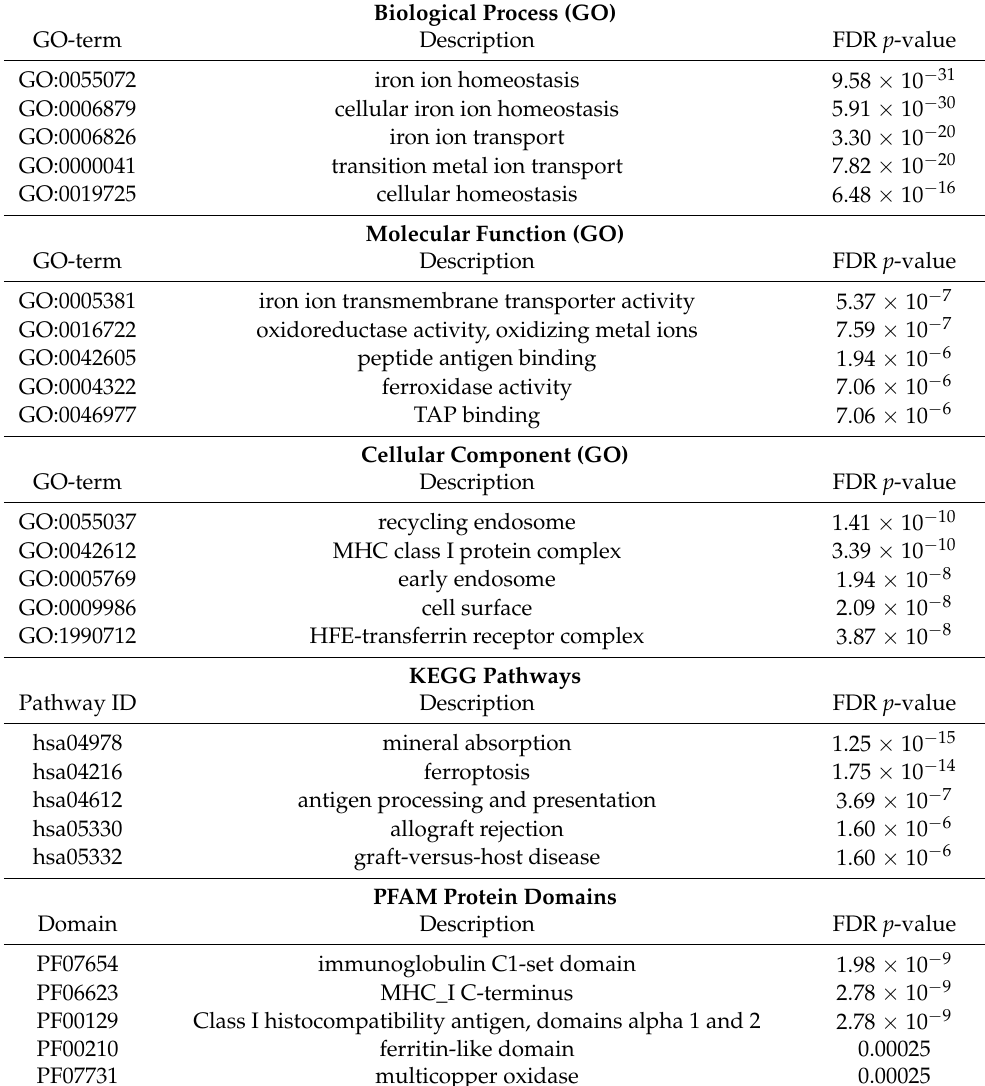
Table 2. Results of the functional enrichment analysis of the